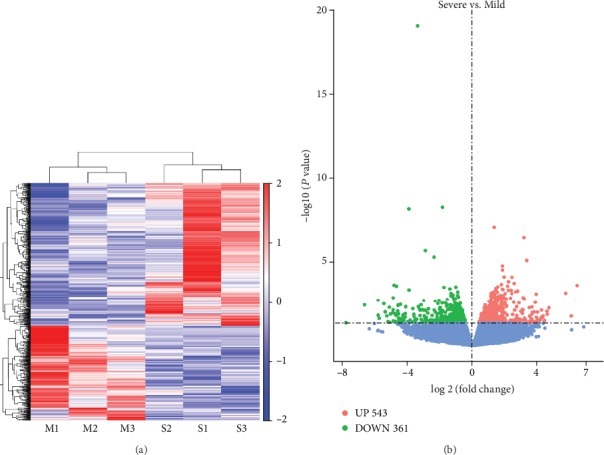
High-throughput sequencing of differentially expressed mRNAs. (a) Hierarchical cluster analysis of differentially expressed mRNAs. (b) Volcano plot of differentially expressed mRNAs. Mild: children with mild RSV-associated pneumonia; Severe: children with severe RSV-associated pneumonia.